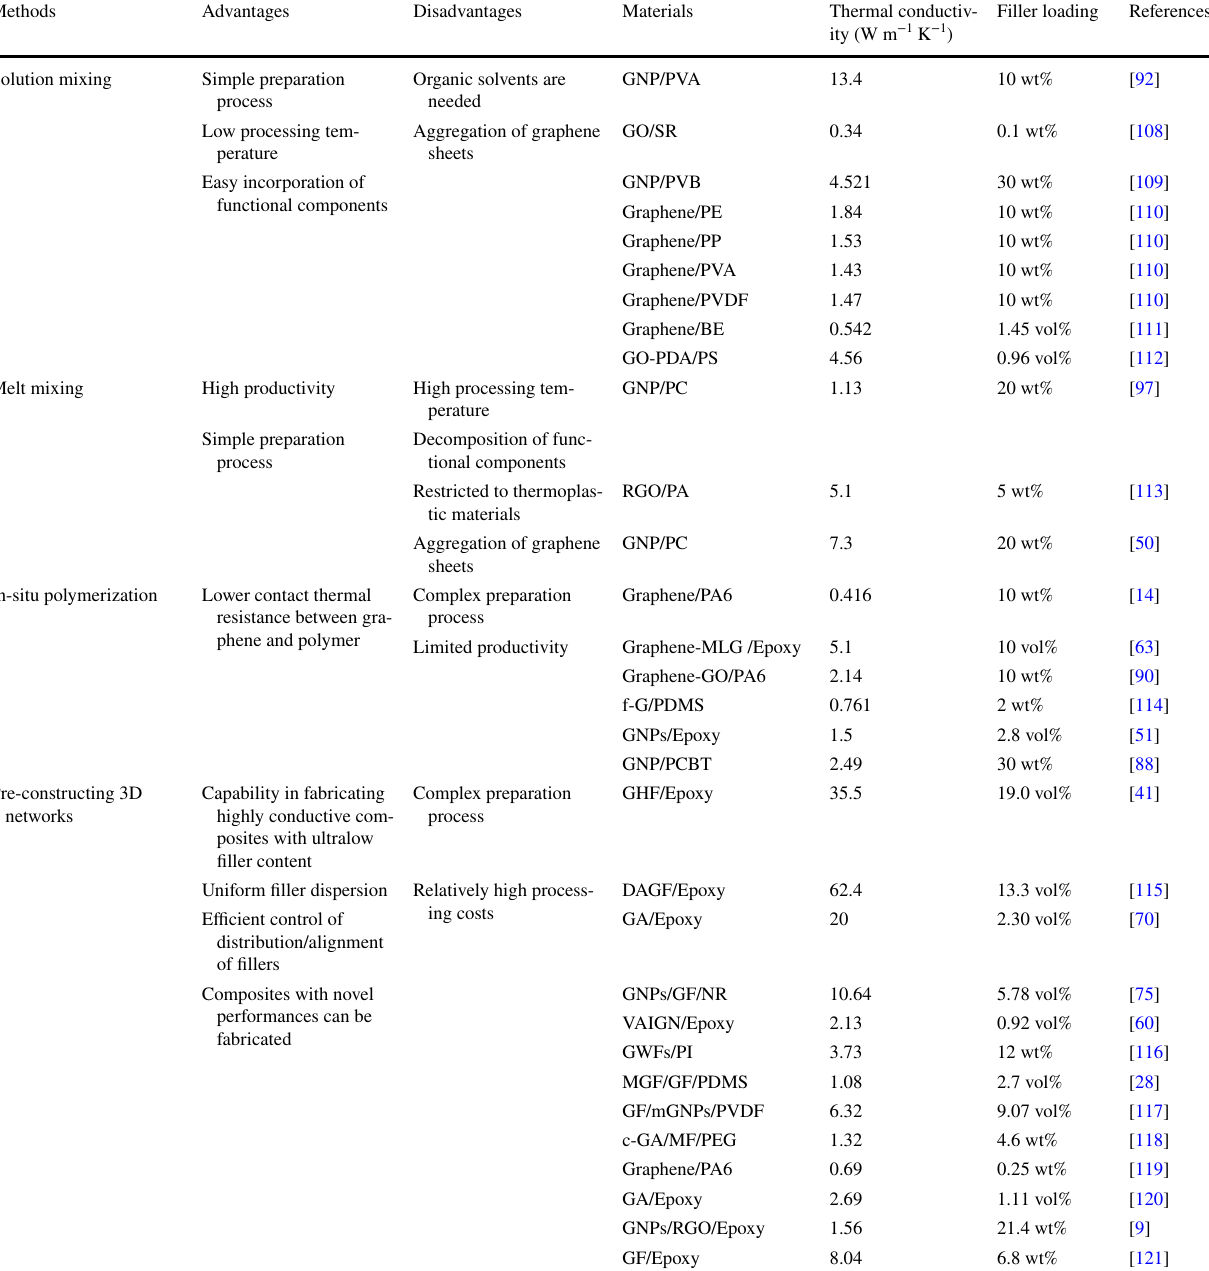
Table 1 Comparison of fabrication methods for thermally conductive graphene/polymer composites